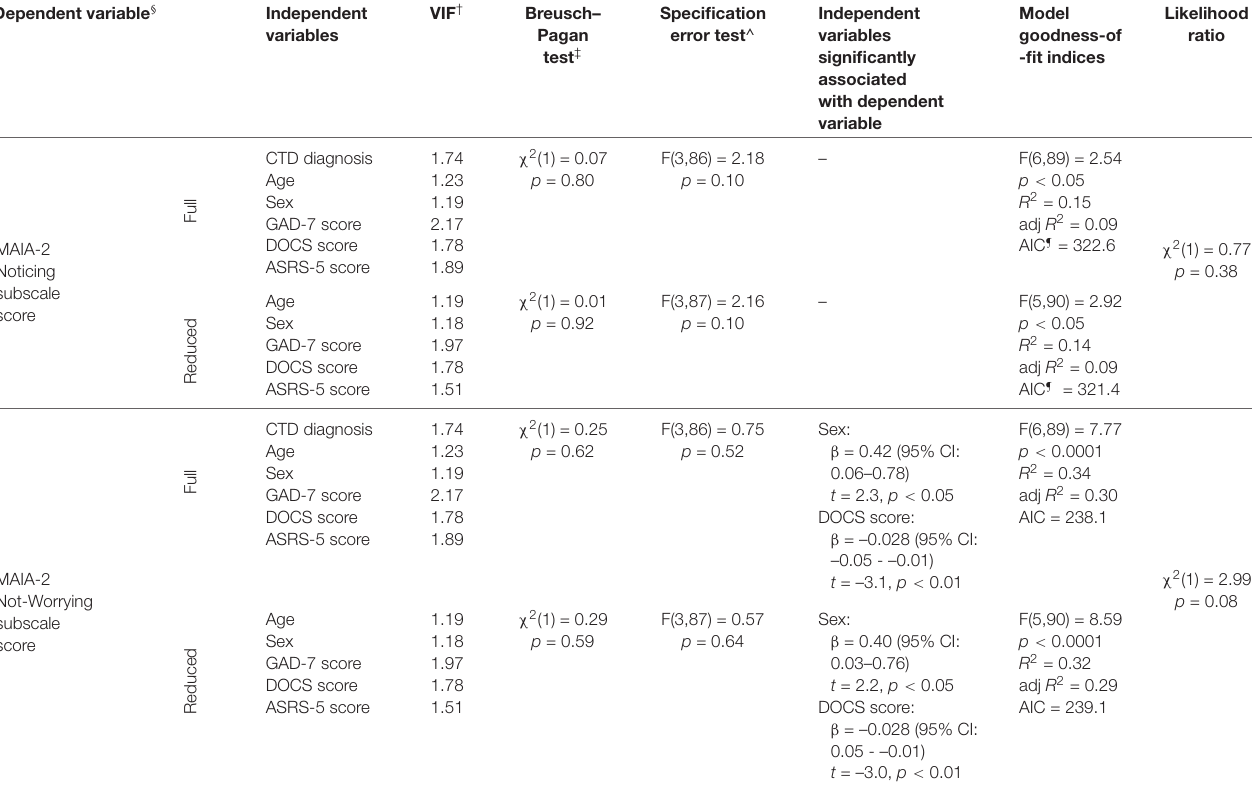
TABLE 3 | Regression model diagnostics and results for MAIA-2 Noticing and Not-Worrying